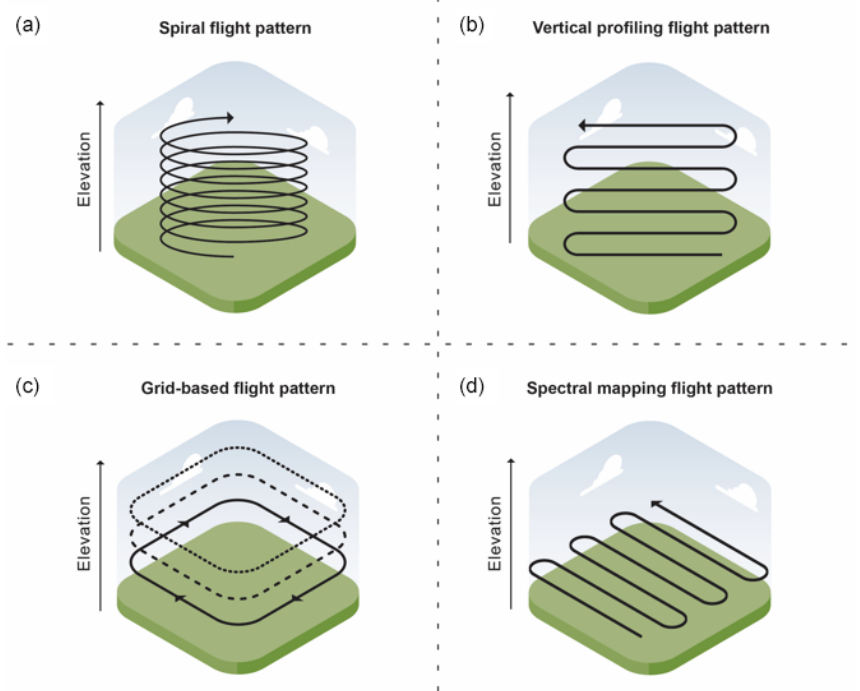
Figure 4. Four typical flight patterns used during the deployment: (a) spiral pattern; (b) vertical profile (“ladder”) pattern; (c) grid-based (“parking garage”) pattern; and (d) spectral mapping (“lawn mowing”) pattern.